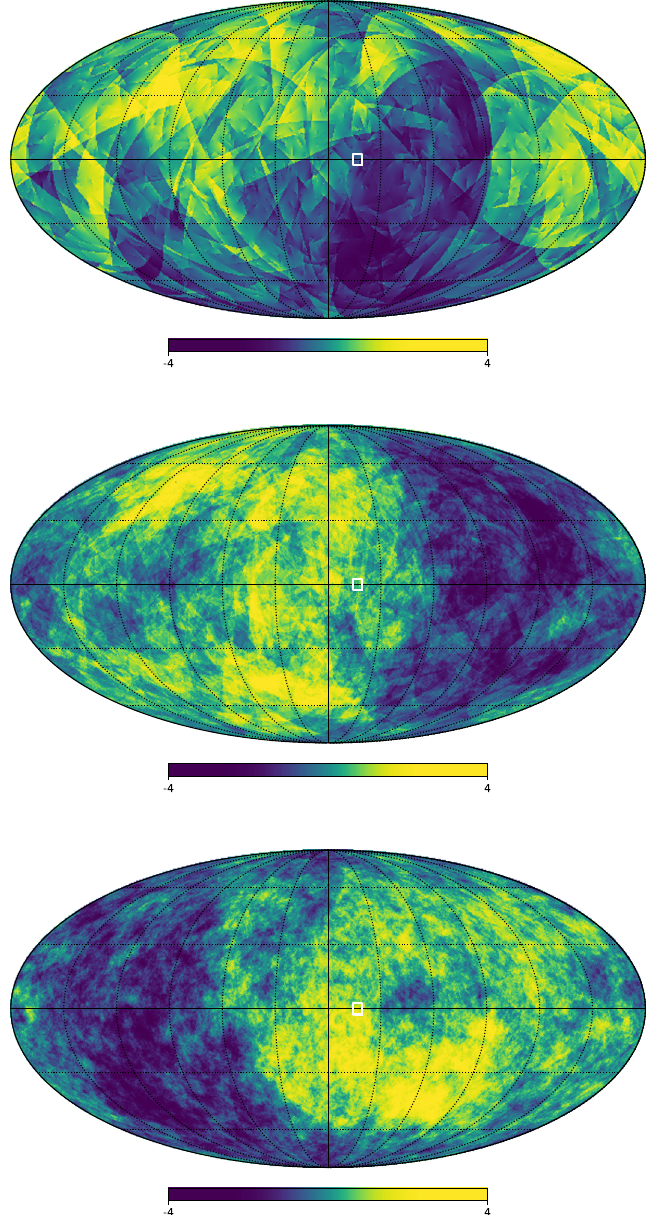
Figure 4 . The polarization rotation angle map (cid:8)(^ (cid:13) ) for photons from a simulation of axion strings described in the text. The three (cid:12)gures, from top to bottom, have the number of string per Hubble patch (cid:24) = 1 ; 10 ; 100 respectively. The rotation is normalized by 1 = ( radians. The contribution from long strings today is clearly visible. The white boxes mark the boundary of the region shown in (cid:12)gure 7.